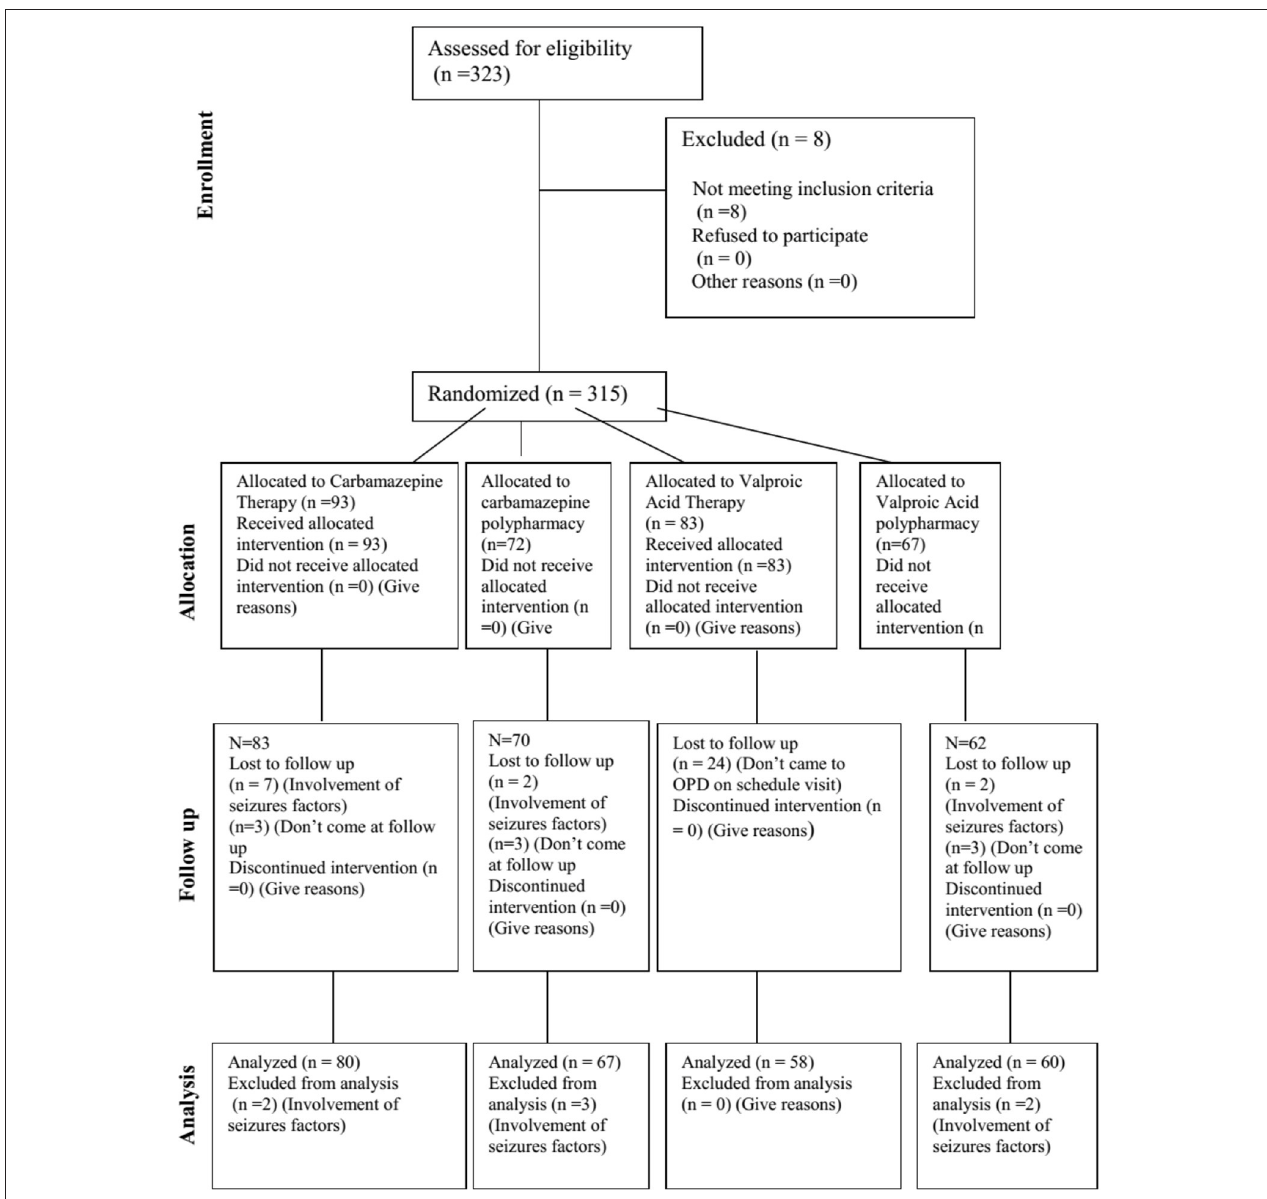
FIGURE 1 | CONSORT diagram. CONSORT diagram showing the flow of participants through each stage of a randomized trial.